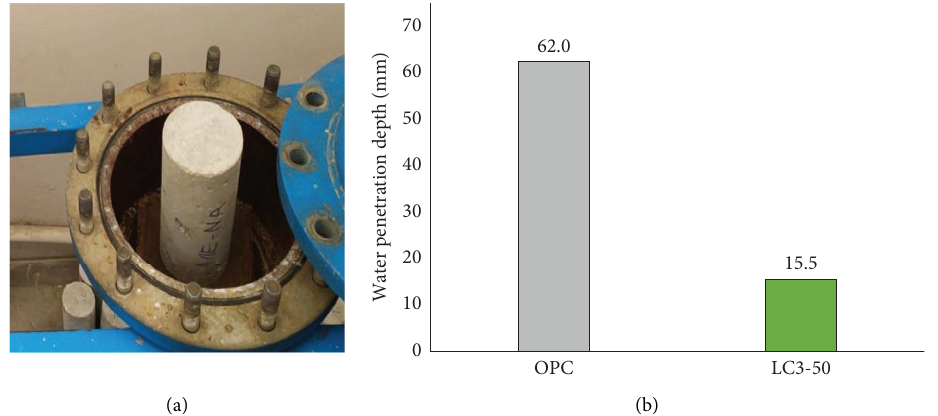
Figure 6: Results of the water penetration test. (a) Water permeability test of the cylinder in a test machine. (b) Results of the permeability test cast from LC 3 -50 and OPC concrete.